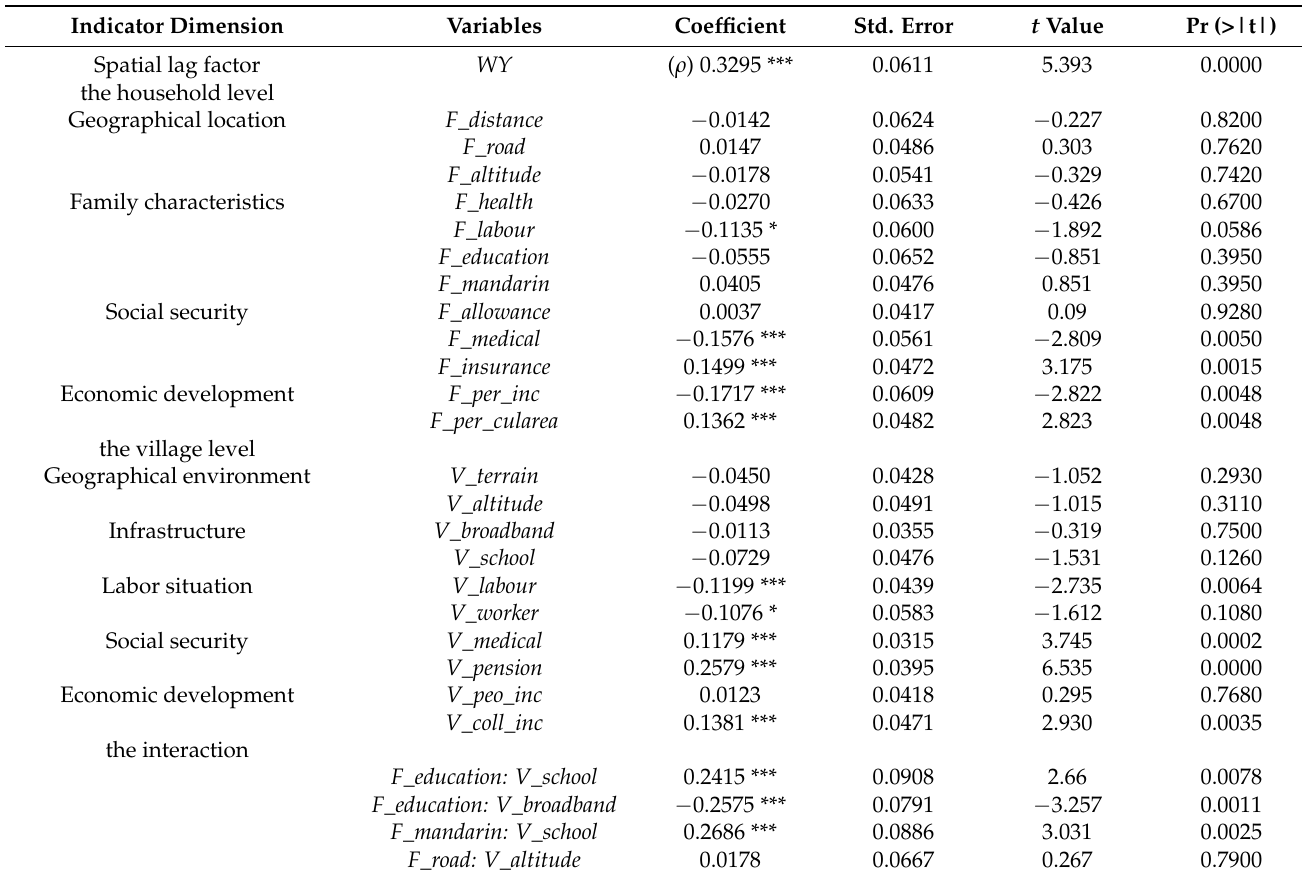
Table 5. The detection results of the HSTRM